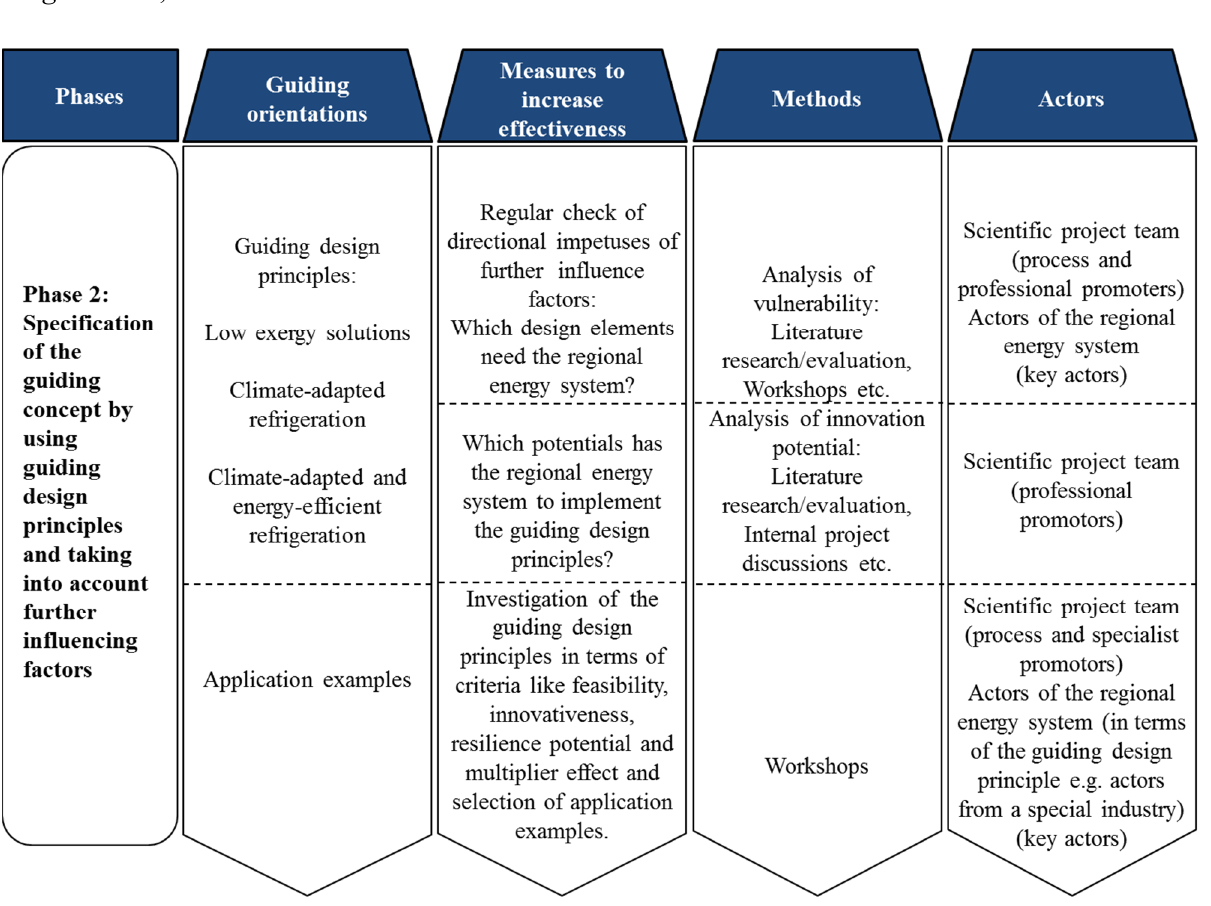
Figure 4. Phase 2 of the regional guiding orientation